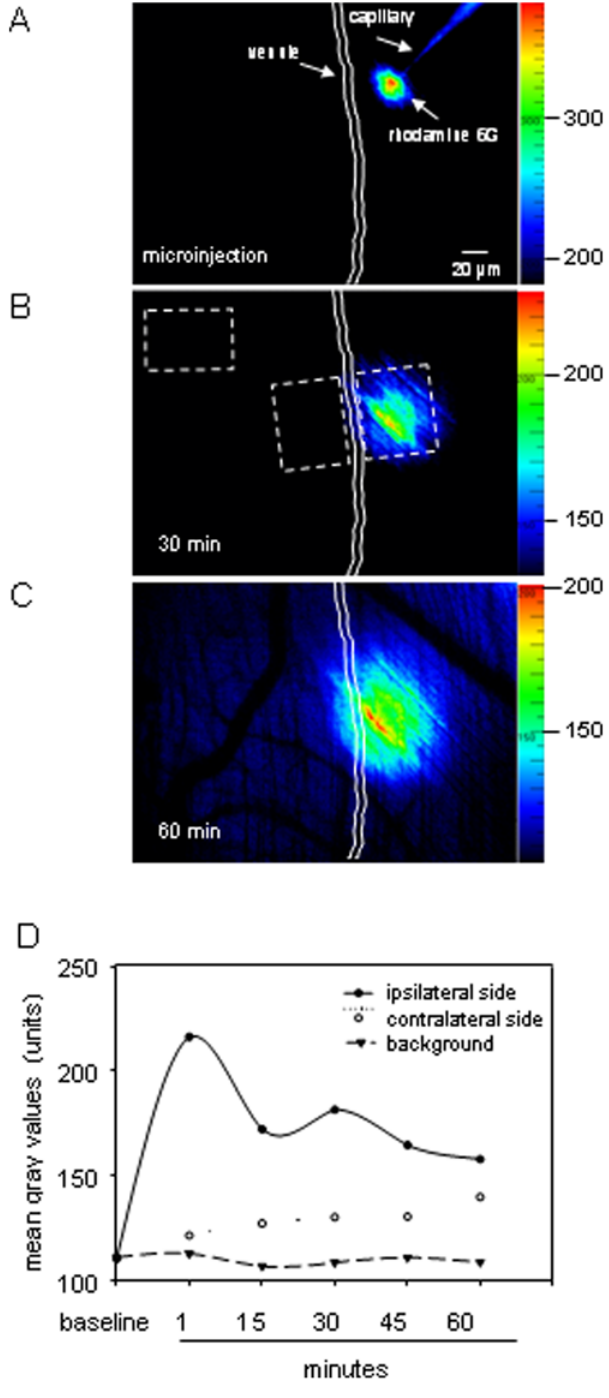
Figure 2. Tissue distribution of rhodamine 6G after microin- jection. A-C: In vivo microscopy images show tissue distribution of rhodamine 6G at 1 (A), 30 (B), and 60 min after microinjection (C). Three regions of interests 100 6 75 m m (depicted in B) within the cremasteric interstitial tissue were analyzed: on the vessel side ipsilateral to the microinjection site, on the contralateral side, and in the interstitial tissue at a distance of 350 m m from the site of microinjection (considered as background). Images are shown with different original color scales to emphasize the fluorescent intensity within 60 min after microinjection. The fluorescence intensity was determined within 60 min; the quantitative data are presented in D; n=7.